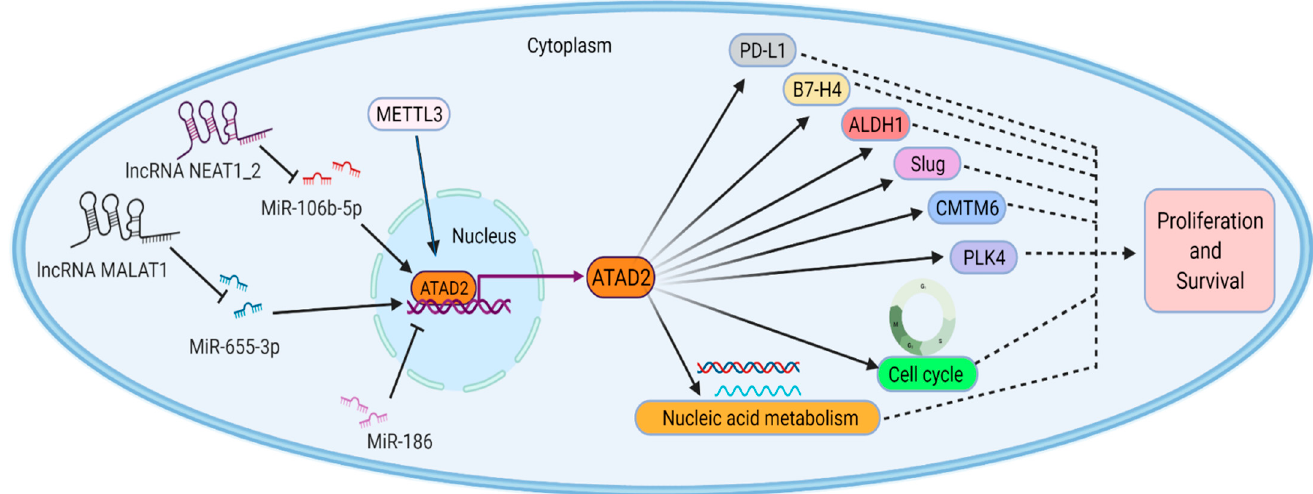
Figure 3. Partial roles of ATAD2 in other types of malignant tumors. lncRNA NEAT1_2 and lncRNA MALAT1 promote ATAD2 expression by repressing miR-106b-5p and miR-655-3p, respectively. Moreover, METTL3 promotes ATAD2 expression, but miR-186 negatively regulates ATAD2